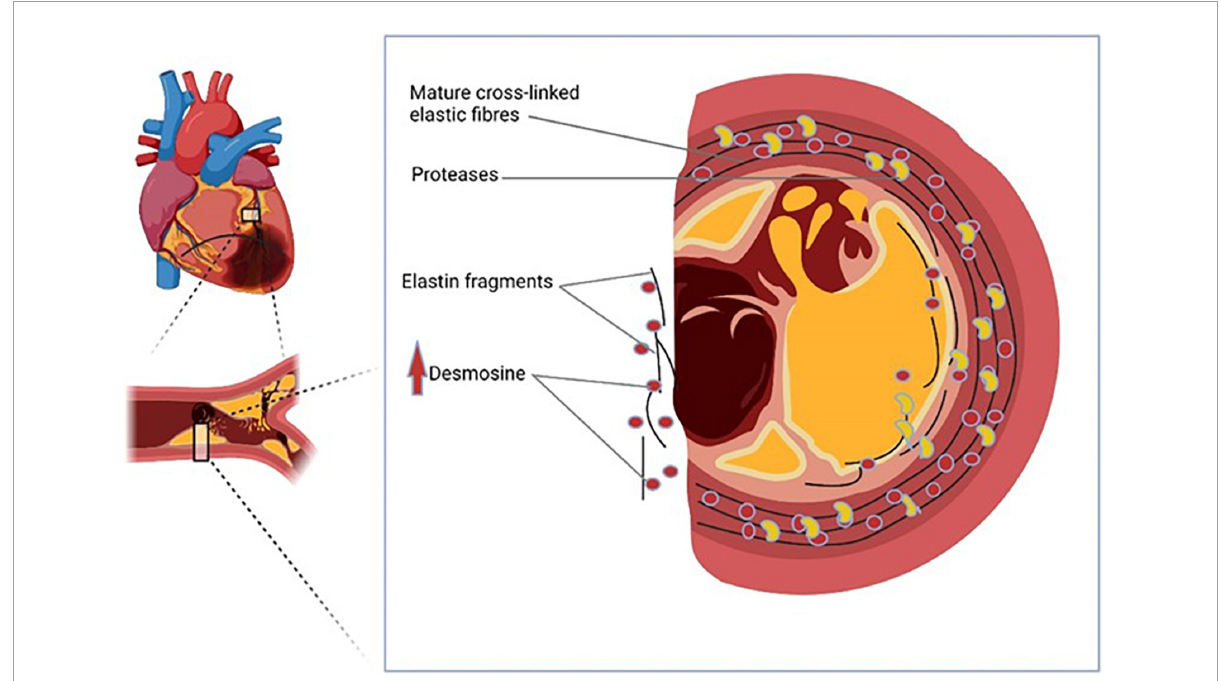
FIGURE2 Plasma desmosine (pDES) is a potential novel biomarker of acute myocardial infarction